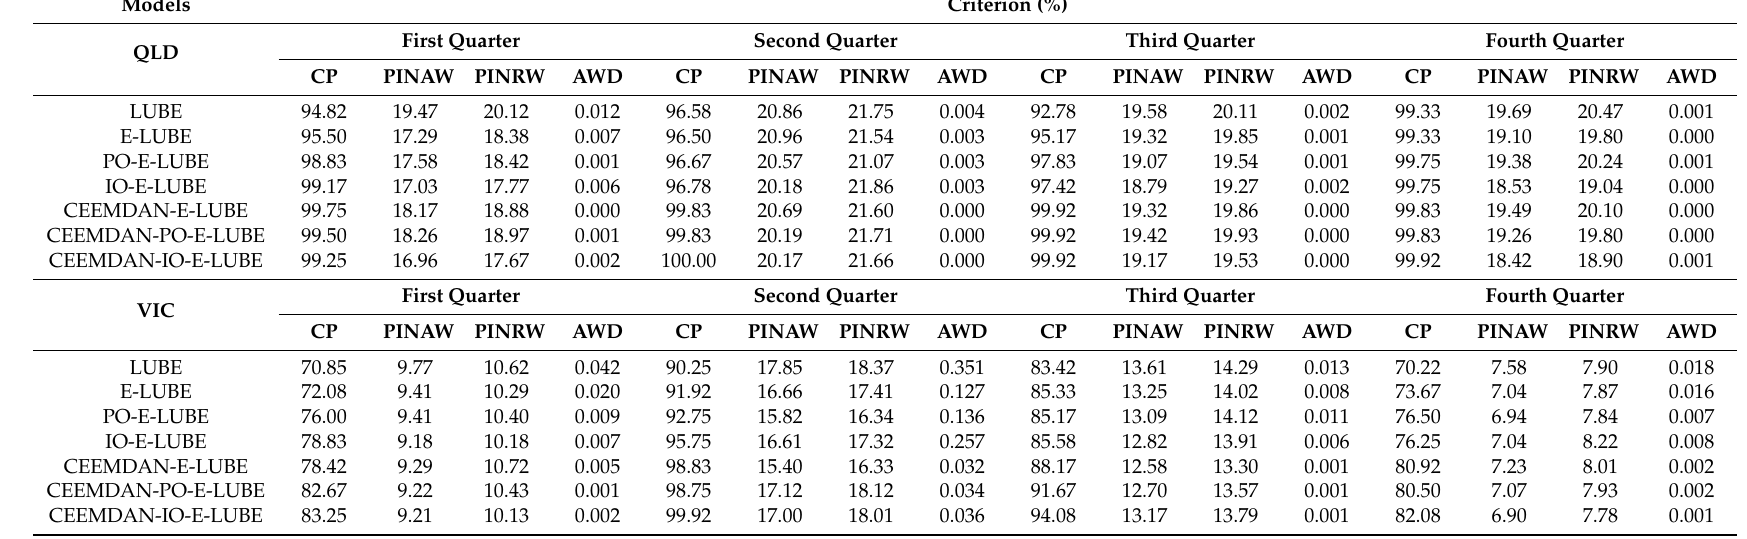
Table 3. Results of different models with α = 0.05 for sample in Queensland (QLD) and Victoria